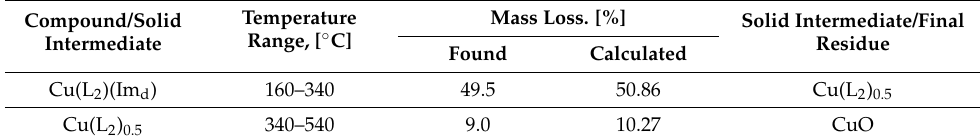
Table 10. TG-DTG analysis data of decomposition of Cu(L 2 )(Im d ).